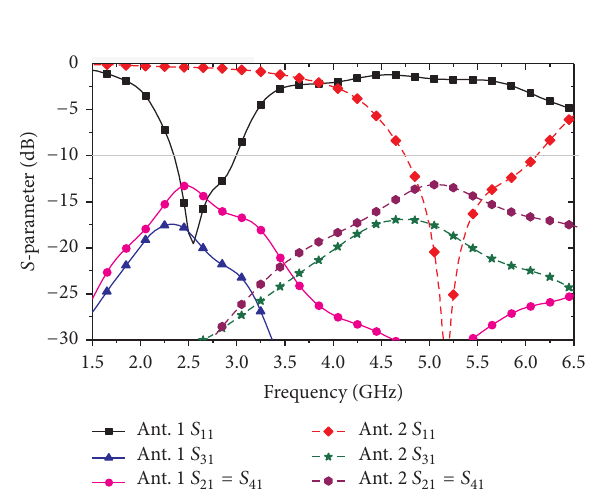
Figure 2: Simulated 𝑆 -parameters of scalable 4-port antenna system for Ant. 1 ( 𝑆 : 1/1) and Ant. 2 ( 𝑆 : 1/2.3) designs.